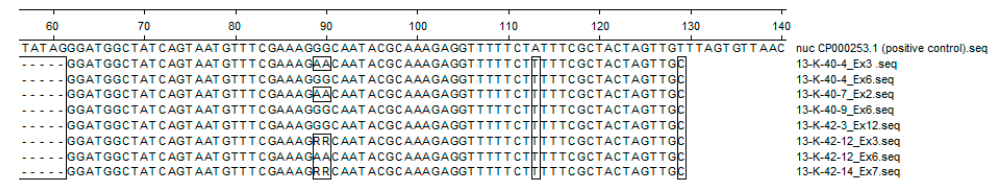
Figure 3. Alignment of the consensus nuc sequence of the historical bone specimens (primer binding sequence was removed) and the nuc gene of the S. aureus reference strain NCTC 8325 (CP000253.1, positive control sample). Bases differing from the reference nuc sequence are framed. Software: MegAlign ™ (DNASTAR, Madison, WI, USA). For the alignment of all amplified forward (fwd.) and reverse (rev.) sequences and the corresponding electropherograms see Supplementary Figures S3 and